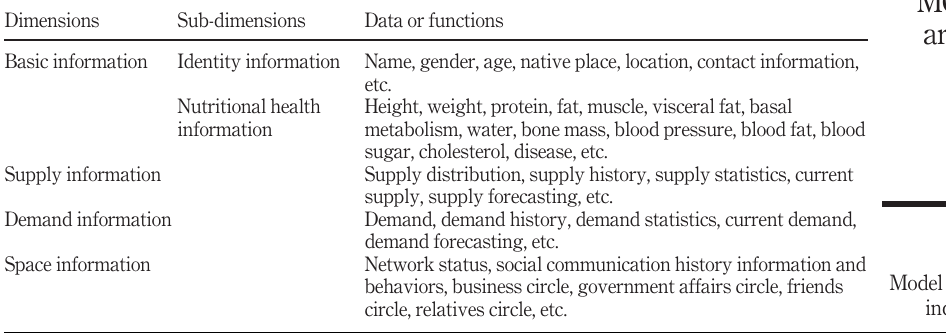
Table III. Model of